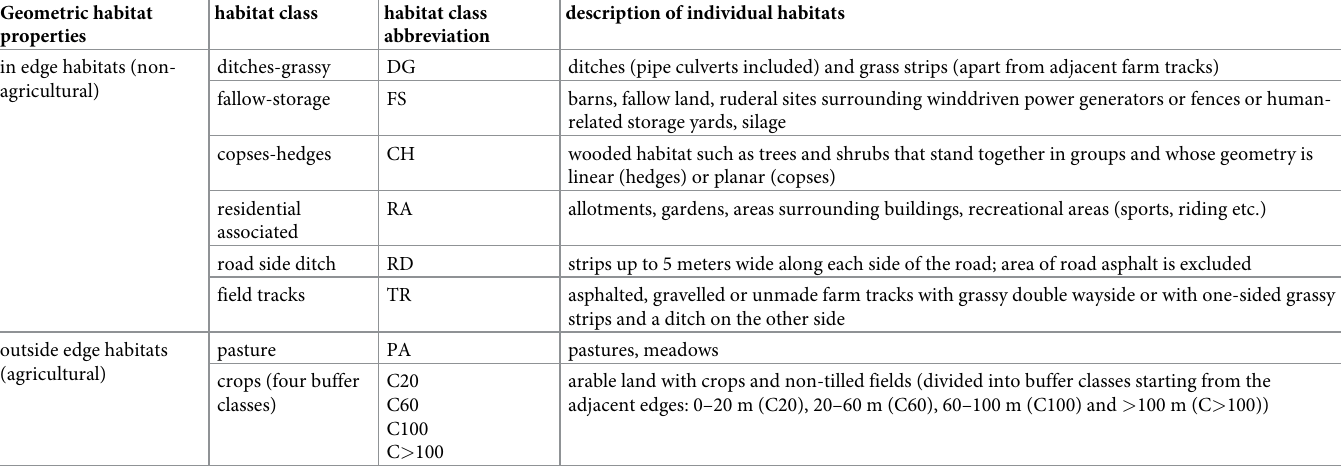
Table 1. Defined habitat classes aggregated from single habitats and separated by edges or areal characteristics. Geometric habitat